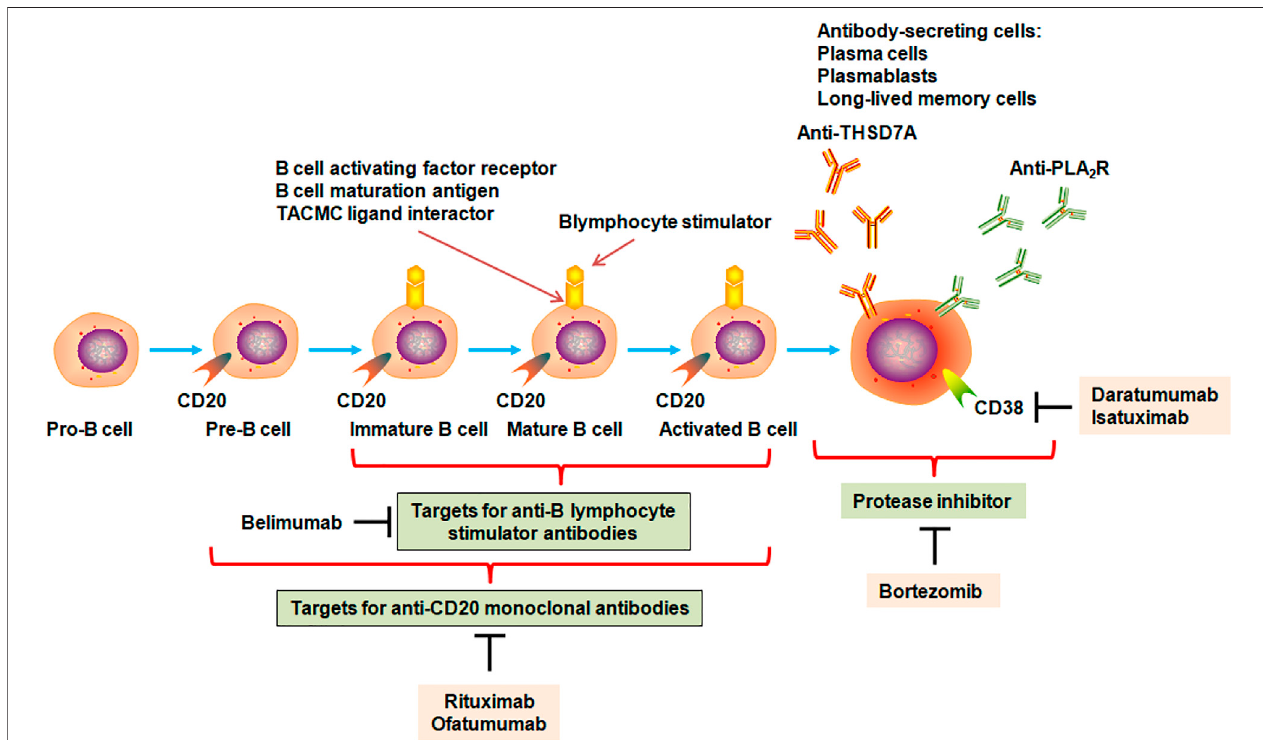
FIGURE 3 | Targets for monoclonal antibodies in B cells for the MN therapy strategy. B cells originated from bone marrow stem cells as pro-B cells and mature to pre-B cells, immature B cells, mature Bcells, and activated B cells, which could form plasmacells, plasmablasts, and long-livedmemory plasma cells thatcould secrete antibodies such as immunoglobulin A, immunoglobulin E, immunoglobulin G, and immunoglobulin M. Autoreactive B-cell clones could generate anti-PLA 2 R and anti- THSD7A antibodies. When B cells became mature, they generated many biomarkers that were considered targets for monoclonal antibodies. Monoclonal antibodiesrituximabandofatumumabcouldbindandinhibitanumberofCD20-positiveBcellsbutnotmatureplasmacells,plasmablasts,andmemoryplasmacellsthat couldnotproduceCD20antigen.PlasmacellsproducedCD38andcouldbeatargetforanti-CD38antibodiesbydaratumumabandisatuximab.Immature,mature,and activated B cells produced receptors for B-lymphocyte stimulator including B-cell activating factor receptor, B-cell maturation antigen, transmembrane activator, and calcium-modulating cyclophilin (TACMC) ligand interactor. Belimumab could inhibit B-cell differentiation into plasma cells by suppressing interaction between B-lymphocyte stimulator and its receptors. Bortezomib, a proteasome inhibitor, could inhibit antibody production by mediating plasma cell apoptosis, while anti-CD38 antibodies daratumumab and isatuximab could directly mediate plasma cell